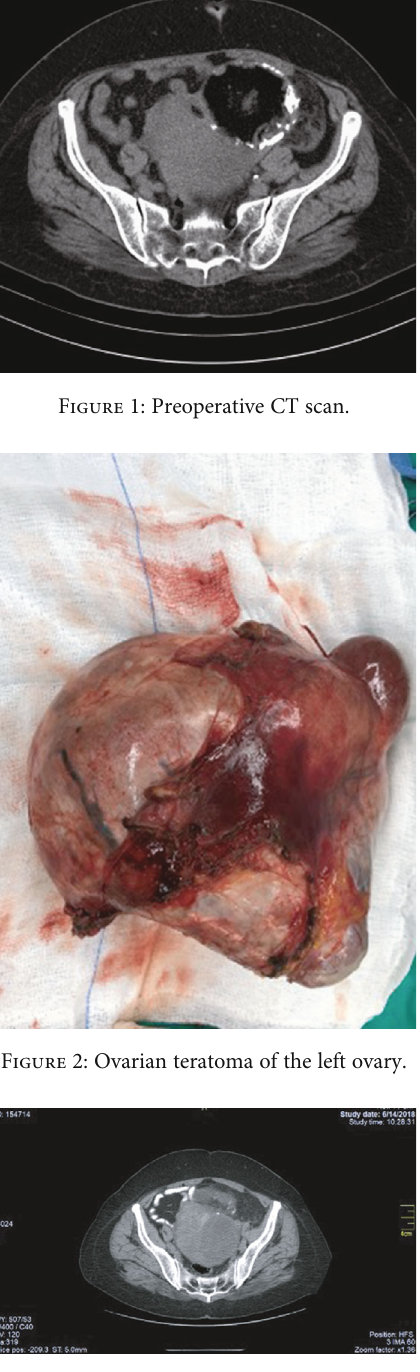
Figure 3: CT scan of the recurrent struma